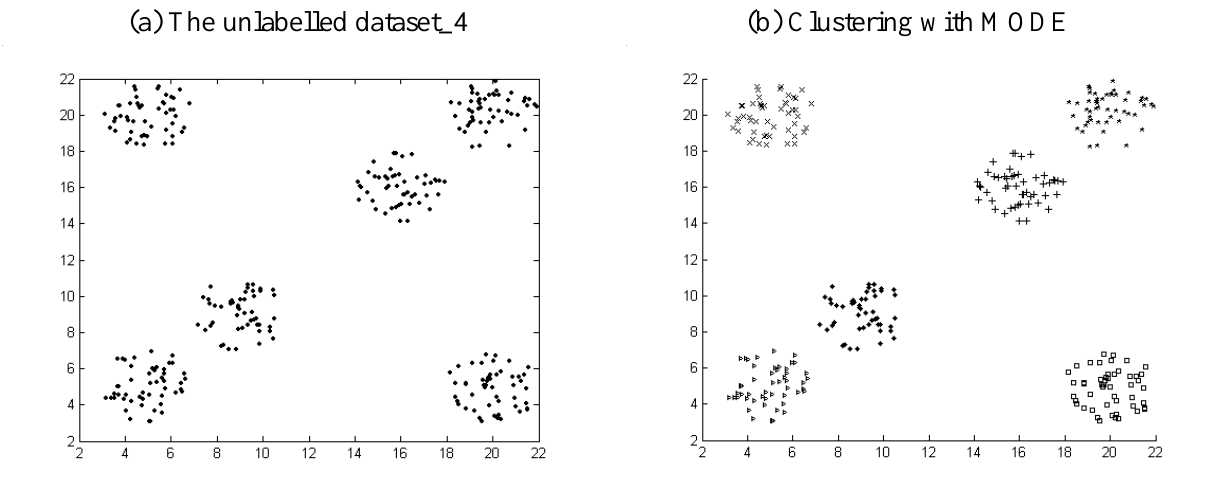
Figure 7. Clustering result for artificial